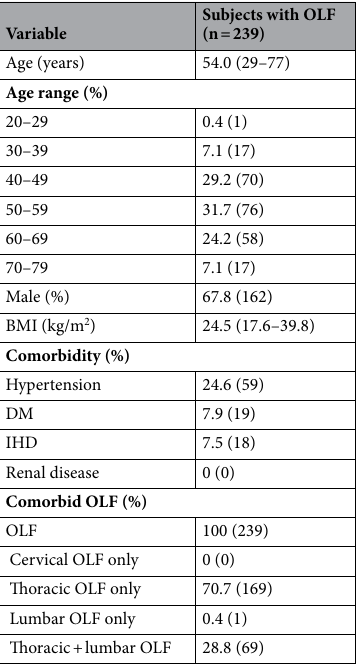
Table 1. Clinical characteristics of the study subjects with OLF. Data are shown as median (minimum– maximum) or as percentage (number). BMI body mass index, OLF ossification of the ligamentum flavum, DM diabetes mellitus, IHD ischemic heart